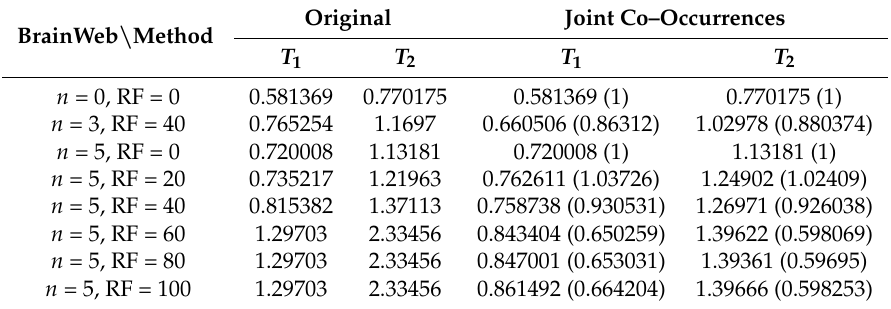
Table 1. Validation for BrainWeb phantom T 1 w and T 2 w images with CJV i of GM and WM tissue regions. A low value indicates improved performance. In parentheses is the ratio of the restored to the original, CJV ratio . Low values and less than unity indicate improved performance. i